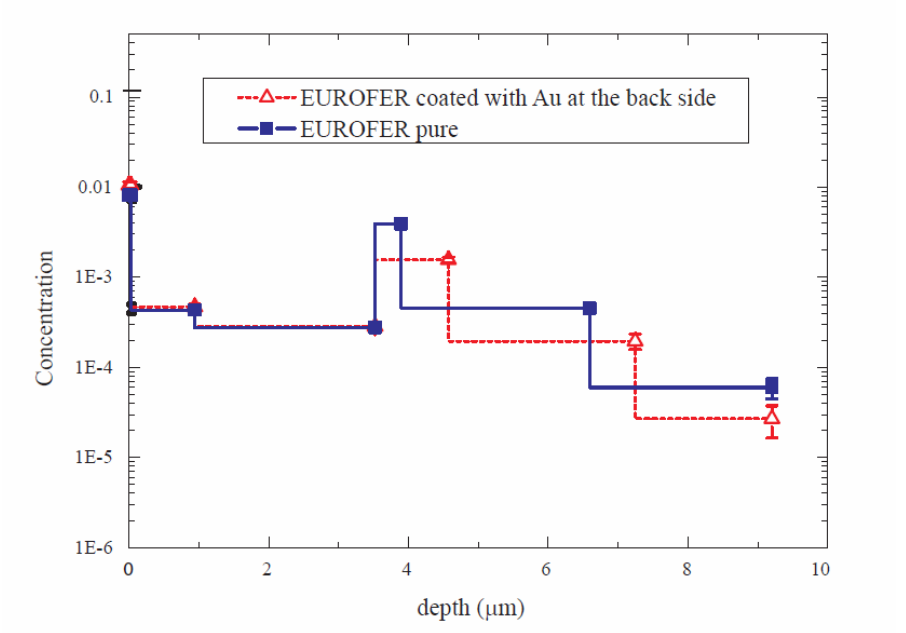
Figure 3 – Deuterium depth profile for the EUROFER samples annealed in vacuum at 873 K for 1h and then exposed to deuterium plasma at RT to a fluence of F = 6×10 24 Dm 2 (-) not coated with Au and (---) coated with a 130 nm thick Au layer Slika 3 – Dubinski profil deuterijuma za uzorke EUROFER-a zagrevane u vakuumu na 873K u trajanju od 1h, a zatim ozra č ene plazmom deuterijuma na sobnoj temperaturi